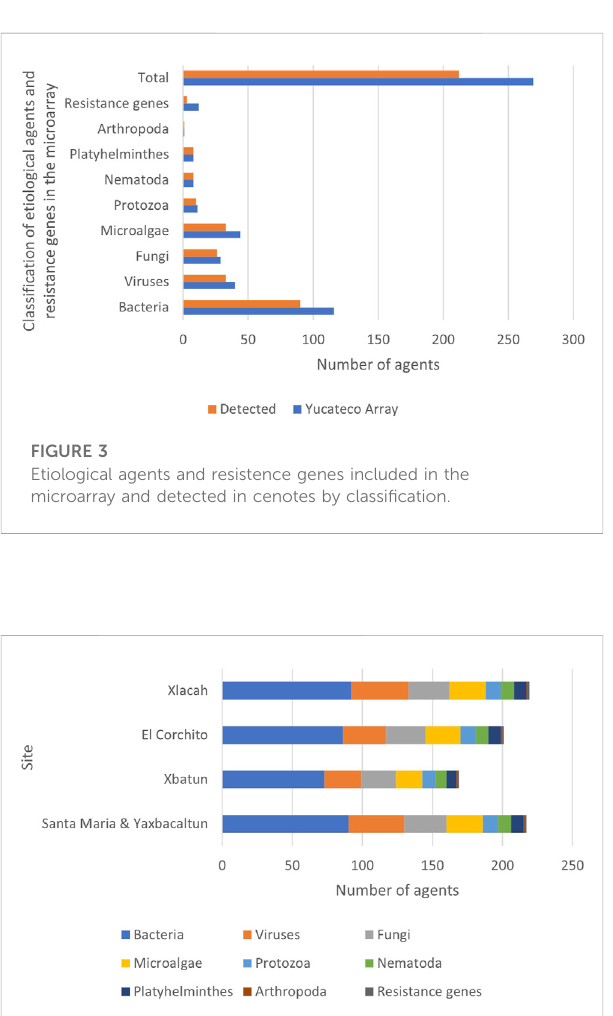
FIGURE 4 Etiological agents detected by cenote. The number of